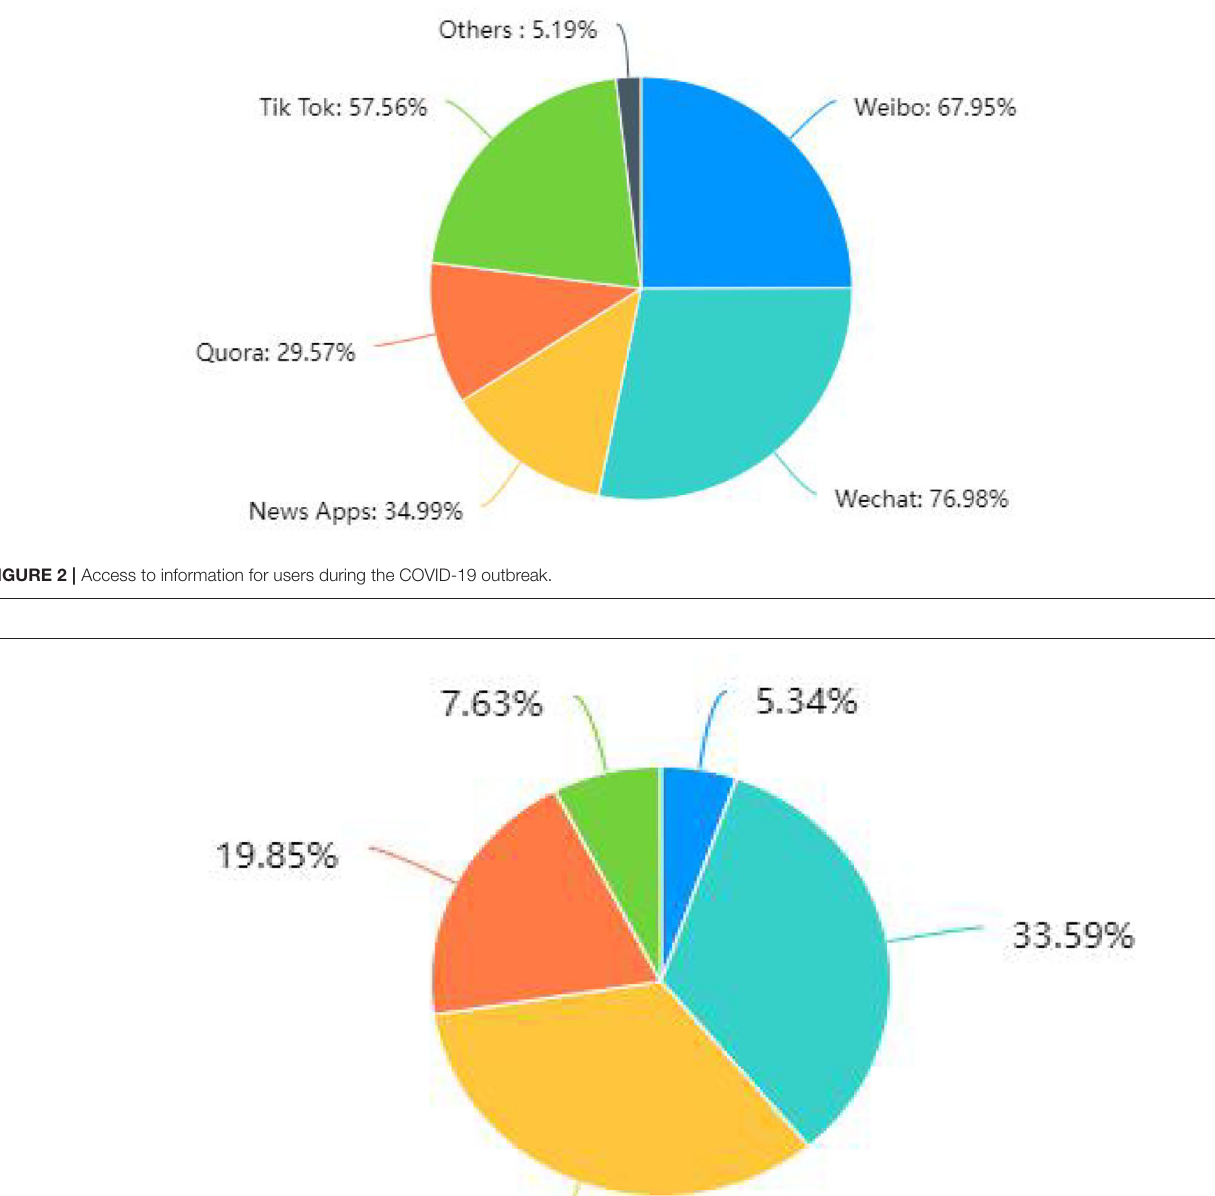
allowing users to add their own commonly used platforms, other in the figure, accounting for (5.19%), with users filling in Douban, RED, and video